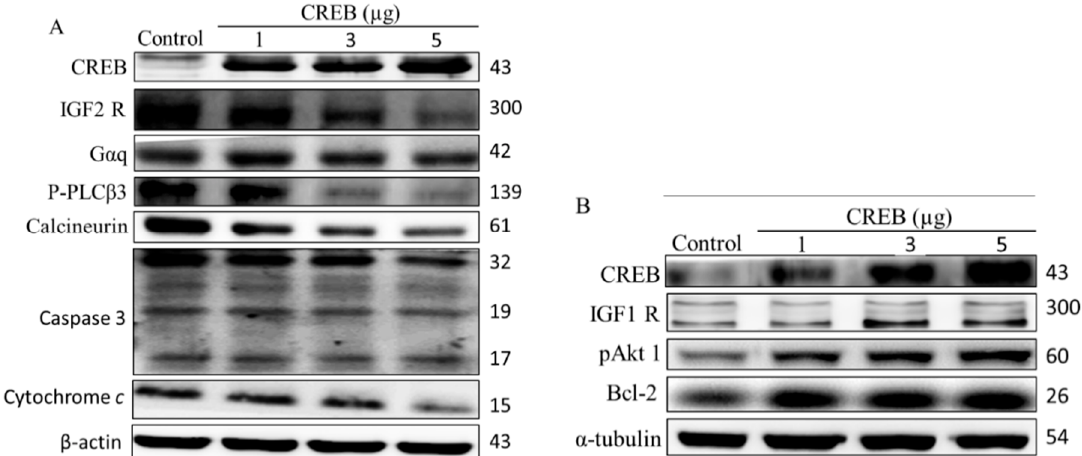
Figure 1. Cyclic adenosine monophosphate (cAMP) responsive element-binding protein (CREB) is involved in the regulatory IGF1R and IGF2R cell signaling pathways in H9c2 cells. To assess the role of CREB in IGF1R and IGF2R signaling pathways, protein levels under normoxia were measured by Western blotting ( A , B ). H9c2 cardiomyoblast cells were transiently transfected with 1–5 μ g of CREB plasmid for 24 h.